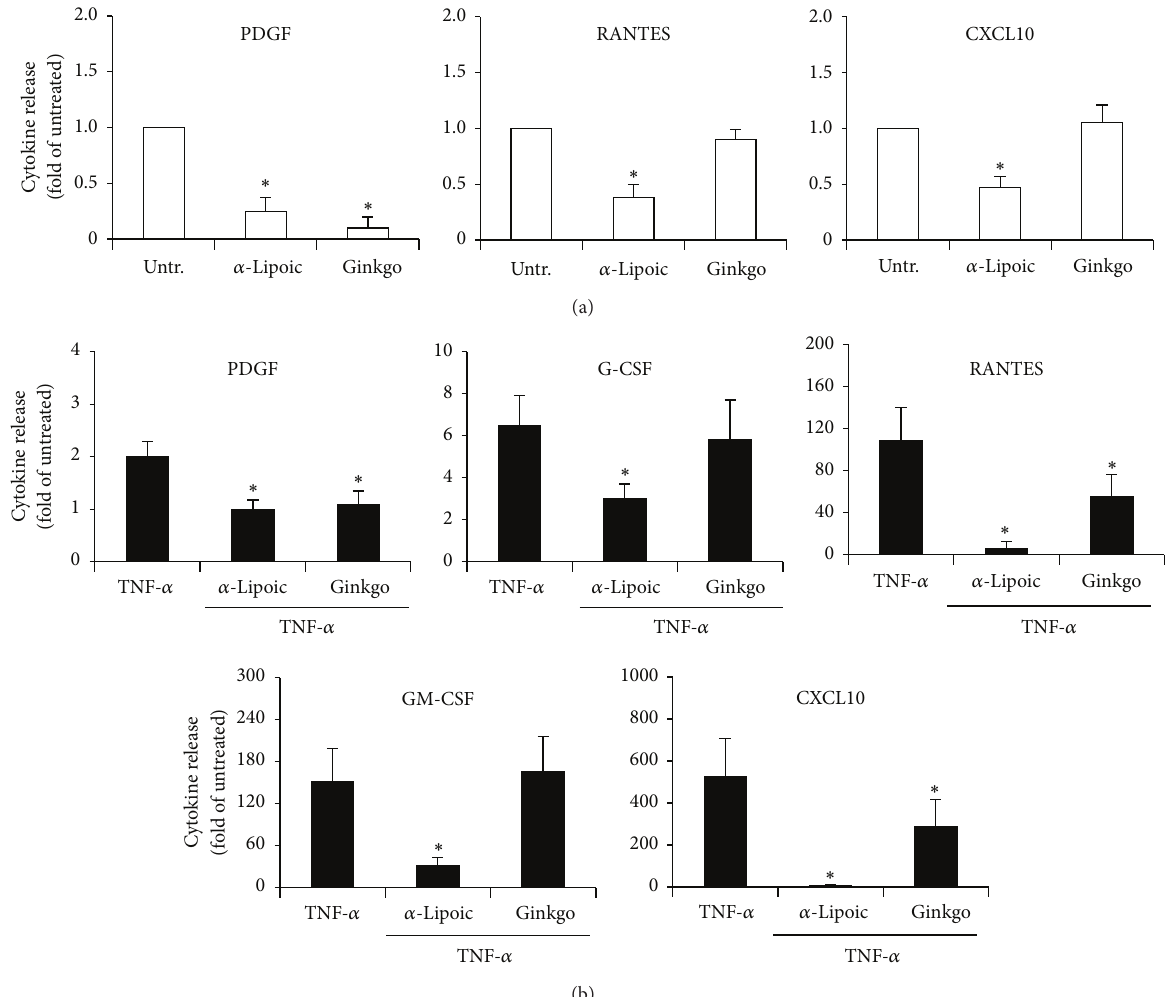
Figure 3: Inhibitory effects on cytokines/chemokines release of 𝛼 -Lipoic acid and Ginkgoselect phytosome in pathological VEC cultures. Cytokines/chemokines levels were measured in culture supernatants of endothelial cells treated for 24 hours with 𝛼 -Lipoic acid or Ginkgoselect phytosome used alone (a) or in combination with TNF- 𝛼 (1 hour of pretreatment with 𝛼 -Lipoic acid or Ginkgoselect phytosome before addition of TNF- 𝛼 ) (b). Results are expressed as fold of induction with respect to the untreated cultures (set to 1). Data are expressed as means ± SD. ∗ 𝑃 < 0.05 compared to untreated (a) or TNF- 𝛼 treated cultures